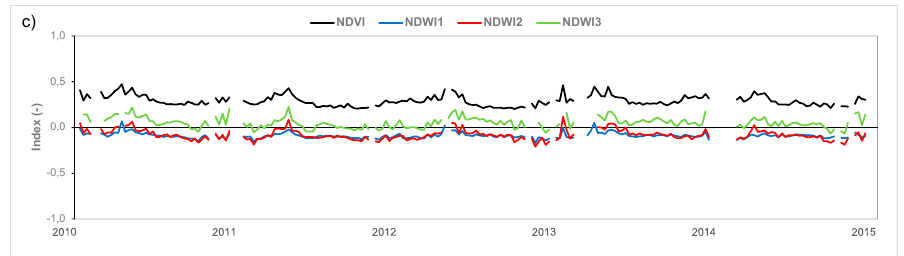
Figure 2. Temporal cycle of the input parameters: ( a ) SSM; ( b ) LST; ( c ) NDVI and NDWI for the REMEDHUS average during the study period (years 2010 to 2015).